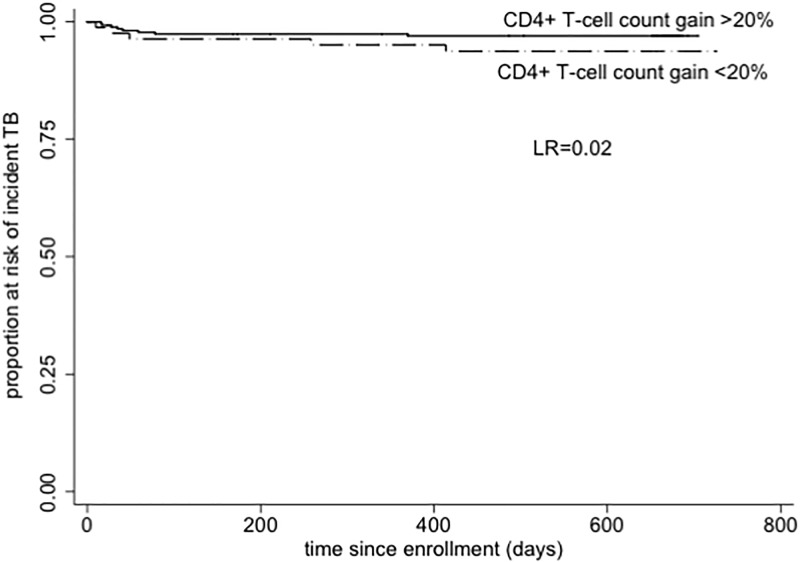
Kaplan Meier plot of time to incident TB in patients with poor immunological response.Participants who failed to achieve a CD4+T-cell count increase of at least 20% of the baseline counts by 6months of follow-up were classified as poor immunological responders.